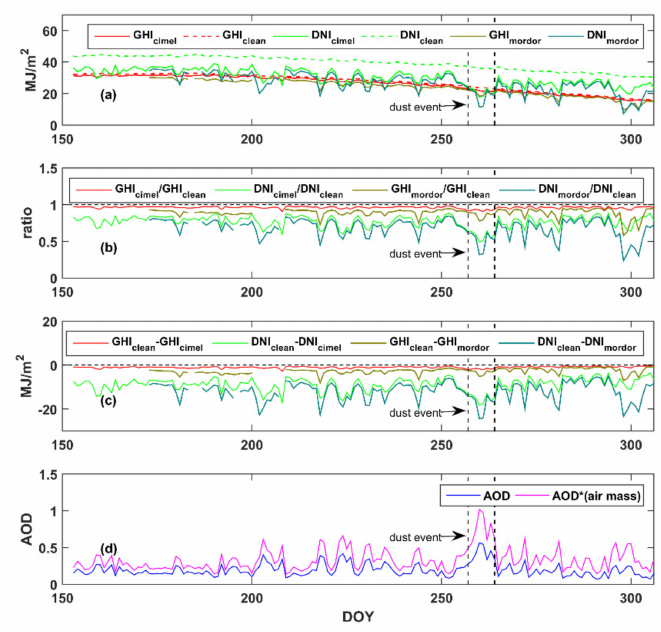
Figure 11. ( a ) Daily modeled GHI and DNI for clean (aerosol- and cloud-free)-skies (GHI clean and DNI clean ), for cloudless-skies (GHI cimel and DNI cimel ), and measured GHI and DNI (GHI mordor and DNI mordor ), ( b ) ratios between the GHI and DNI for cloudless- and all-skies (modeled and measured respectively) with the corresponding aerosol-free cases, ( c ) differences between the modeled cloud- free daily GHI and DNI from the corresponding clean-sky quantities, and differences between the measured daily GHI and DNI and the corresponding clean-sky quantities, and ( d ) daily average AOD at 500 nm from CIMEL (blue line) and daily average AOD multiplied with the average daily air mass (purple line). The graphs are for DOY 153–305